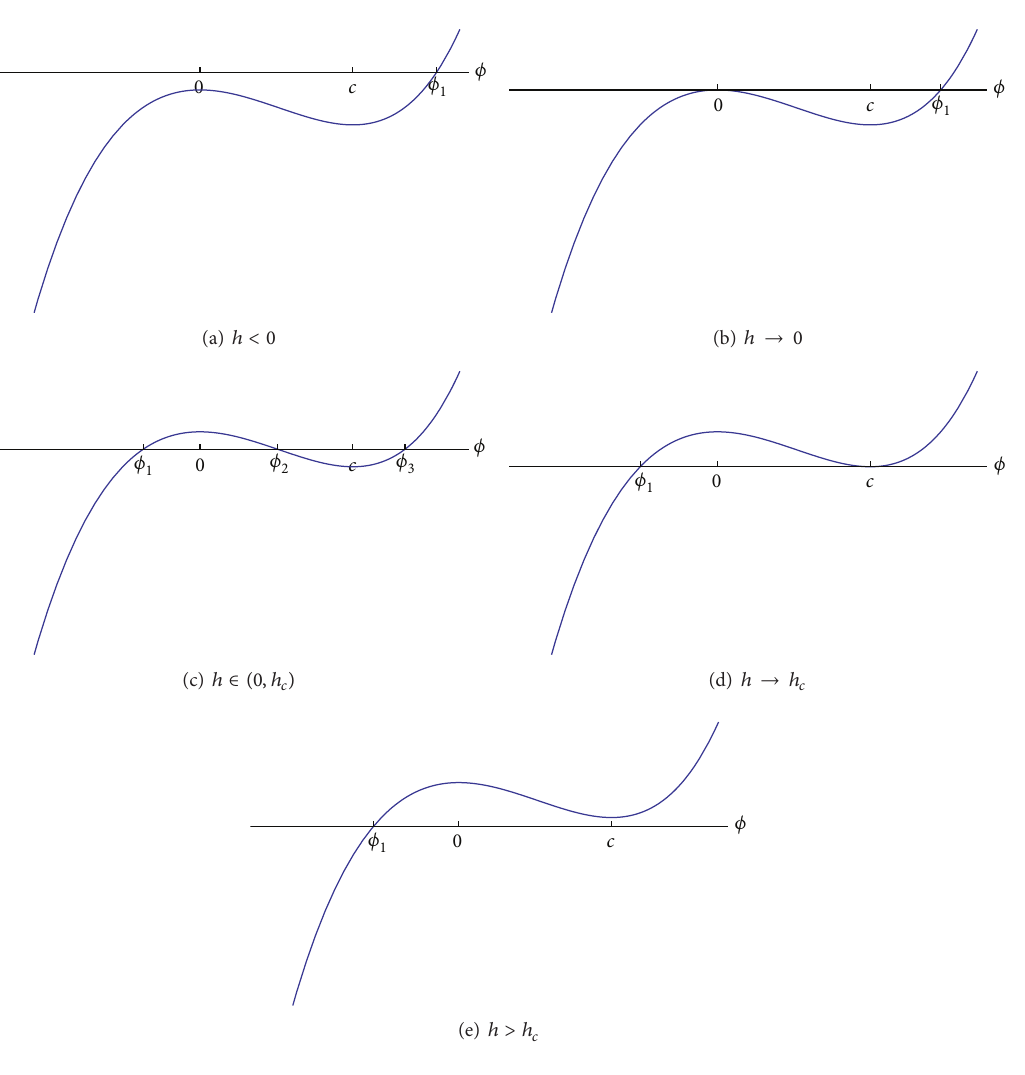
Figure 9: The graph of 𝐹(𝜙) as 𝑐 0 ≥ 𝑐